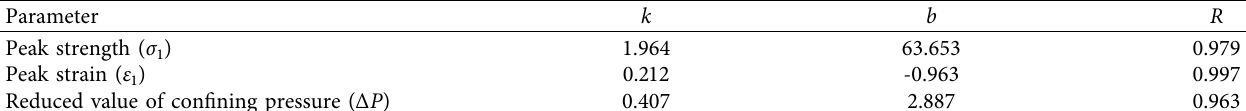
Figure 13: Relationship between confining pressure and peak strength, peak strain, and reduction of confining pressure under soft rock protective layer mining. Table 3: k , b , and correlation coefficients.